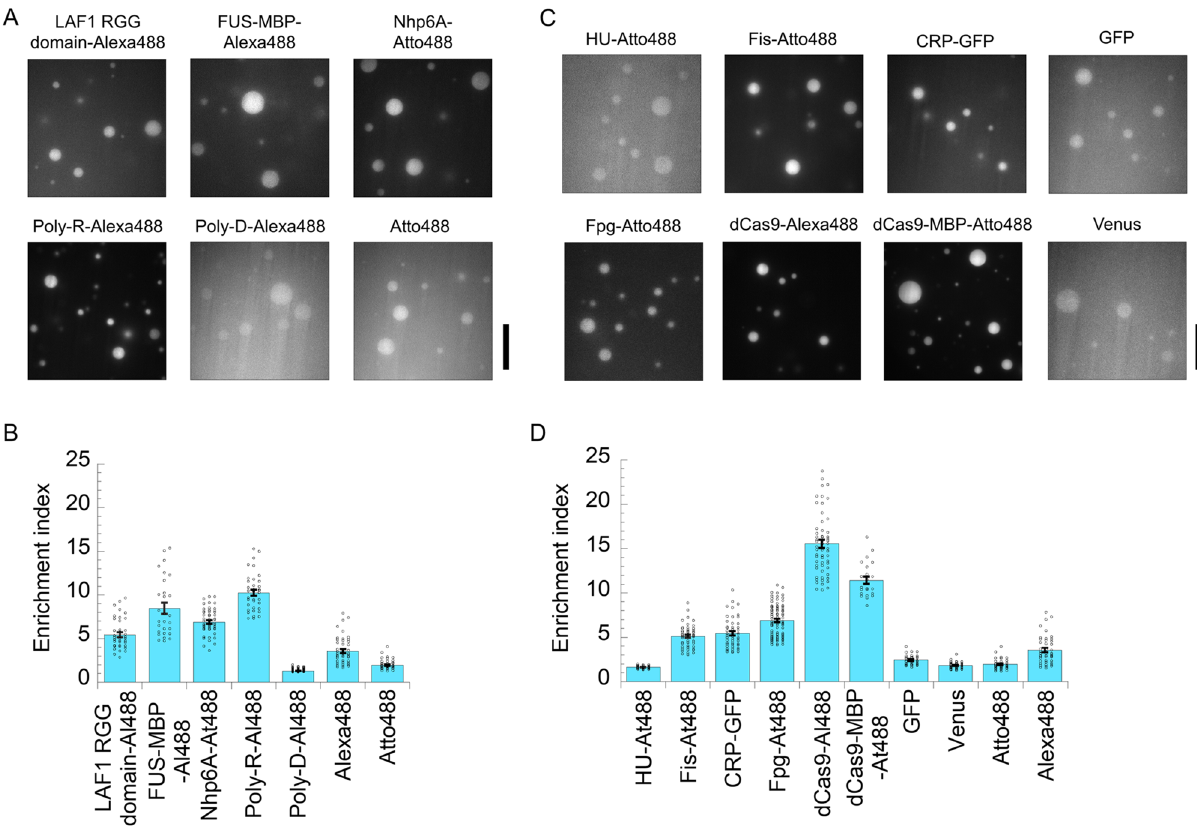
Figure 2. Structural properties of guest proteins do not determine recruitment into liquid p53 tetramer droplets. ( A ) Fluorescent images of labeled intrinsically disordered proteins (IDPs) and artificial polymers in non-labeled p53 tetramer droplet solution. Alexa488-labeled LAF-1 RGG domain, FUS–Alexa488, Nhp6A– Atto488, Poly-R–Alexa488, and Poly-D–Alexa488 are displayed. ( B ) Enrichment index (EI) of the guest IDPs and artificial polymers into non-labeled p53 tetramer droplet. At488 and Al488 denote Atto488 and Alexa488, respectively. Significant difference of the average EI values for all IDPs and artificial polymers from Alexa488 or Atto488 was confirmed using Welch’s t test with α = 0.05. ( C ) Fluorescent images of labeled folded and fluorescent proteins in non-labeled p53 tetramer droplet solution. HU–Atto488, Fis–Atto488, CRP–GFP, FPG–Atto488, dCas9–Alexa488, dCas9–MBP–Atto488, GFP, and Venus are displayed. ( D ) EI of the guest folded proteins into non-labeled p53 tetramer droplet. Scale bars in panels B and D denote 20 μm. The errors in panels B and D denote the standard errors. Significant difference of the average EI values for all folded proteins, except for CRP, from Alexa488 or Atto488 was confirmed using Welch’s t test with α = 0.05. Similarly, significant difference of the average EI values between CRP-GFP and GFP was